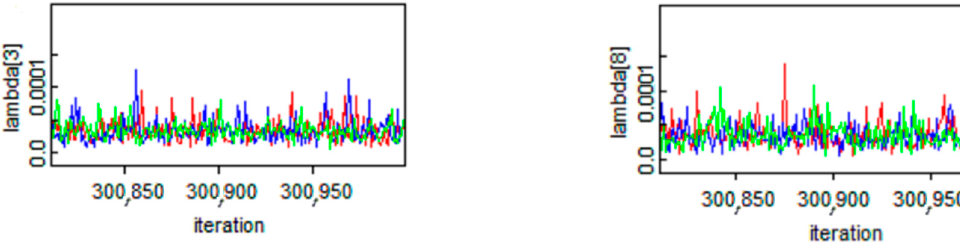
Figure 7. The correlation of α and β .